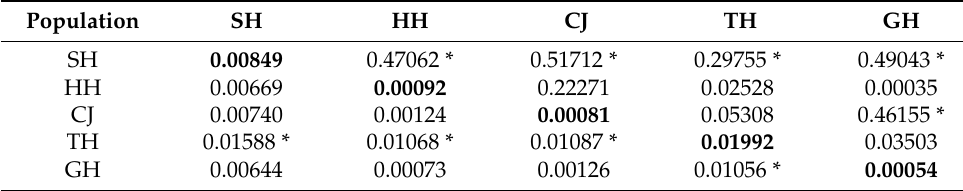
Table 4. Genetic distance and Fst of five different populations.